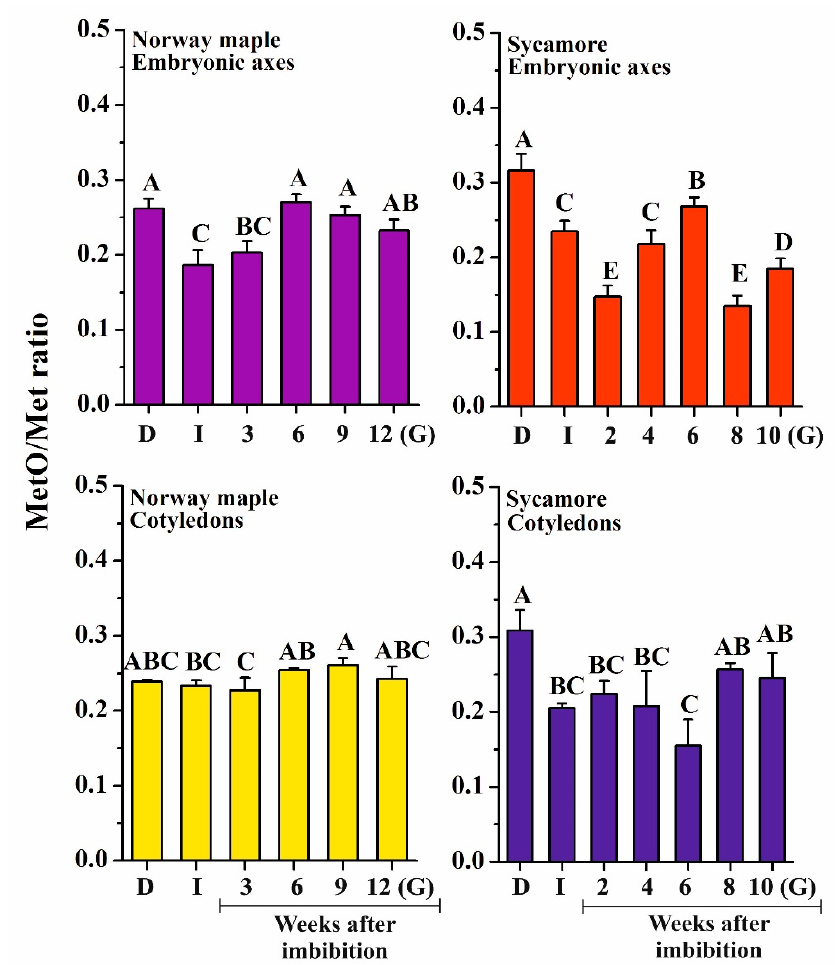
Figure 4. Measurement of protein-bound methionine sulfoxide (MetO) levels in dry and germinating Norway maple and sycamore seeds. Abbreviations: D, Dry seeds; I, Imbibed seeds; G, Germinated seeds. Data are the means of three independent replicates ± the standard deviation. Identical letters indicate groups not significantly differentiated according to Tukey’s test.